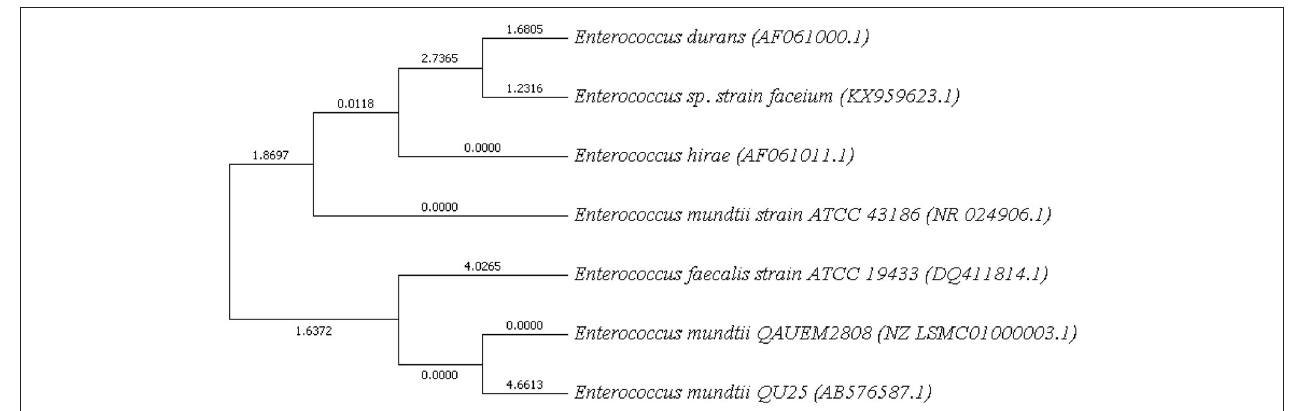
FIGURE 7 | 16s rRNA based Phylogenetic tree of Enterococcus mundtii QAUEM2808.